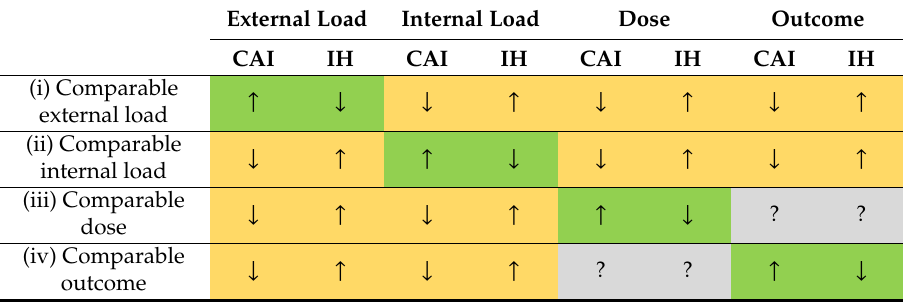
Table 1. Overview of approaches to prescribing physical interventions (PI) and their assumed influence on comparability across di ff erent individuals (CAI) and interindividual heterogeneity (IH) with respect to external load, internal load, dose, and outcome. ↓ indicates a relatively low comparability across di ff erent individuals or a relative low interindividual heterogeneity, whereas ↑ represents a relatively high comparability across di ff erent individuals or a relatively high interindividual heterogeneity; ? shows that we do not currently have enough knowledge to make valid assumptions. Green-shaded field: indicates a relative high compatibility across di ff erent individuals and a low interindividual heterogeneity with respect to the specific category; yellow-shaded field: illustrates a relatively low comparability across individuals and a relative high level of interindividual heterogeneity concerning the specific category; grey-shaded field: shows that it is currently not possible to make assumptions about the level of comparability across individuals and the level of interindividual heterogeneity. External Load Internal Load Dose